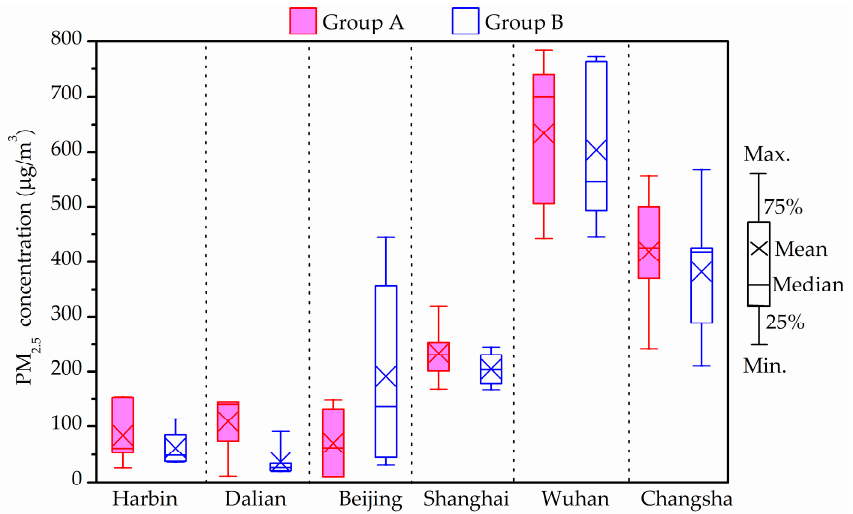
Figure 2. Indoor average fine particulate matter (PM 2.5 ) concentrations in winter.